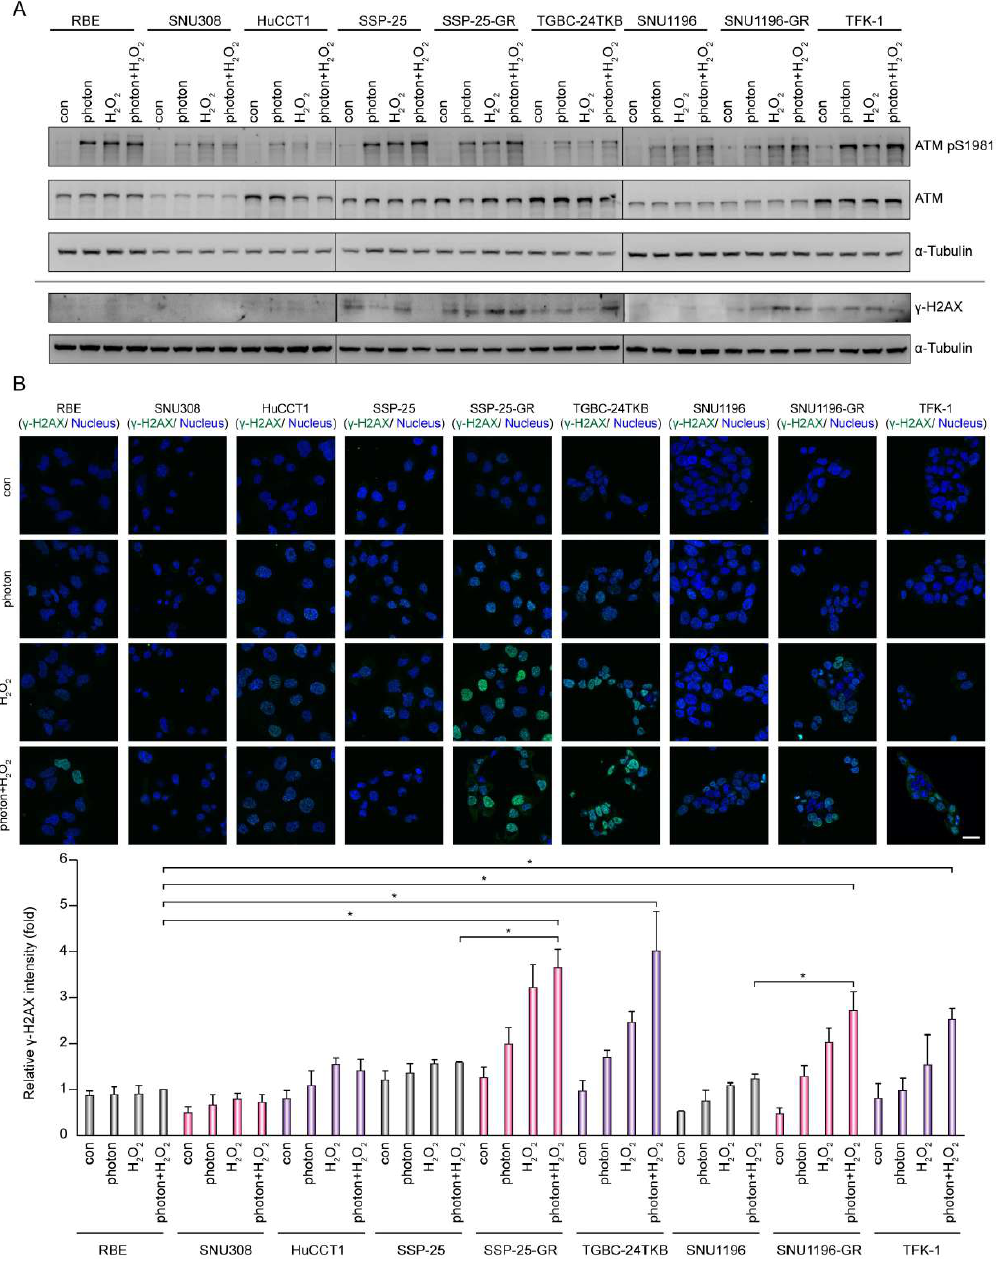
Figure 3. A combination of photons and hydrogen peroxide induces DNA damage in BTC cells. ( A ) Western blots showing the level of histone H2AX Ser139 phosphorylation ( γ -H2AX), ataxia-telangiectasia mutated (ATM) Ser1981 phosphorylation, and total ATM in the BTC cell lines receiving 5 Gy photons or 1 µ M H 2 O 2 for 4 h; α -tubulin was the loading control. ( B ) Top: the BTC cells receiving 5 Gy photons or 1 µ M H 2 O 2 for 4 h were fixed and stained with H2AX Ser139 phosphorylation ( γ -H2AX) and nuclei. Scale bar = 25 µ m. Bottom: the relative fluorescent intensity of γ -H2AX was measured for each field ( n = 3) and expressed as the fold change relative to the level of RBE cells with the treatment of 5 Gy photons or 1 µ M H 2 O 2 for 4 h. The values (means ± SD) are from three independent experiments. * p < 0.05 by Student’s t